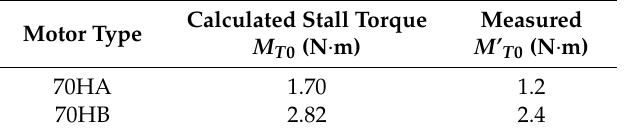
Table 5. Results of maximum stall torque by calculation and measurement.